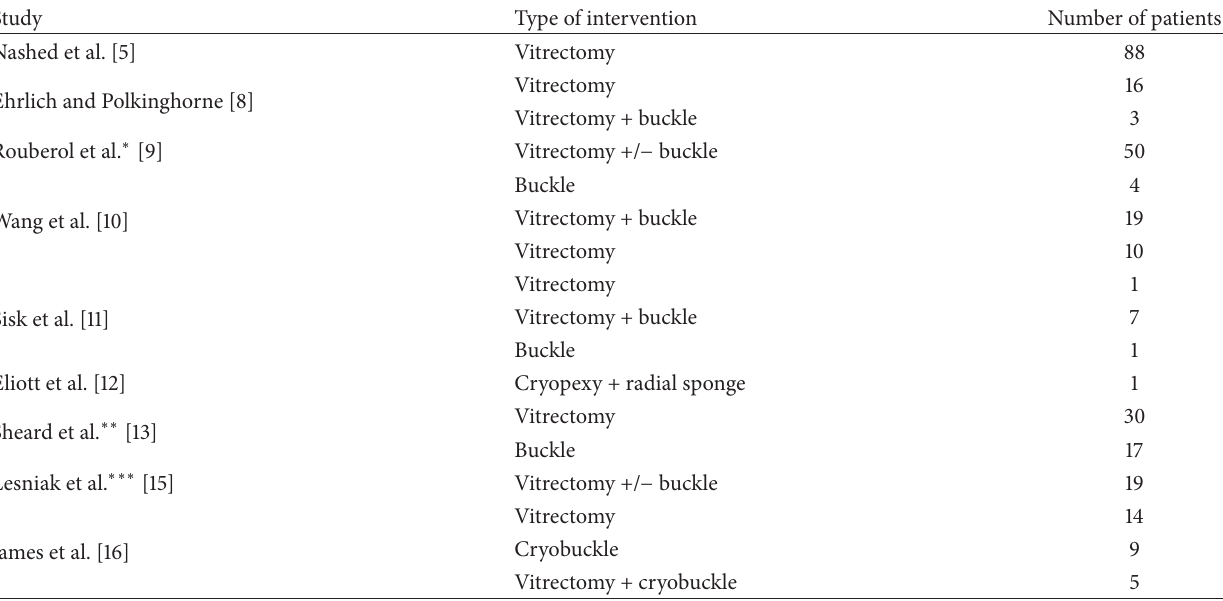
Table 5: Type of